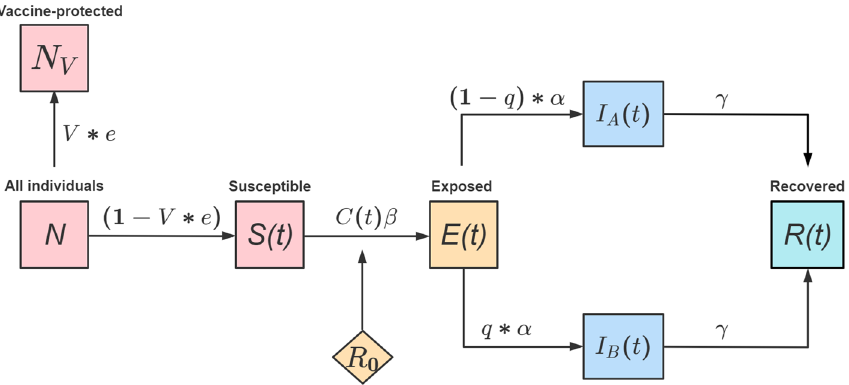
Figure 2. Schematic of the transmission model. N V : The number of unsusceptible people who got vaccinated and protected in Guangzhou; V : The number of people who were fully vaccinated (2 doses) before the outbreak in Guangzhou; e : Vaccine efficacy for preventing infection ; N : The total population in Guangzhou ; S(t) : The number of susceptible people in Guangzhou ; C(t) : Average contact rate per active infectious person ; β : The rate of transmission via contact with active infections; E(t) : The number of exposed people in Guangzhou ; q : The quarantine/isolation effect (1/ t c ); I A (t) : The number of active infections (without quarantine/isolation); I B (t) : The number of quarantined/isolated infections; R 0 : The initial number of recovered people in Guangzhou; R(t) : The number of the recovery in Guangzhou; α : The rate of transmission for the exposed to be infected, which is equal to 1/L; γ : The rate of recovery, which is equal to 1/D; I A can return to the S population and become